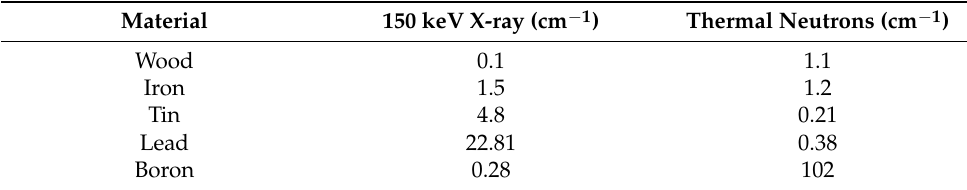
Figure 1. Demonstration of the different attenuation behavior of thermal neutrons ( a ) and X-rays at 150 keV ( b ) for the case of a hard-disk drive (data taken at PSI‘s facilities). Table 1. Linear radiation attenuation coefficients of selected materials for X-rays (at 150 kV) and thermal neutrons (averaged Maxwellian spectrum around 25 meV) [2,3].